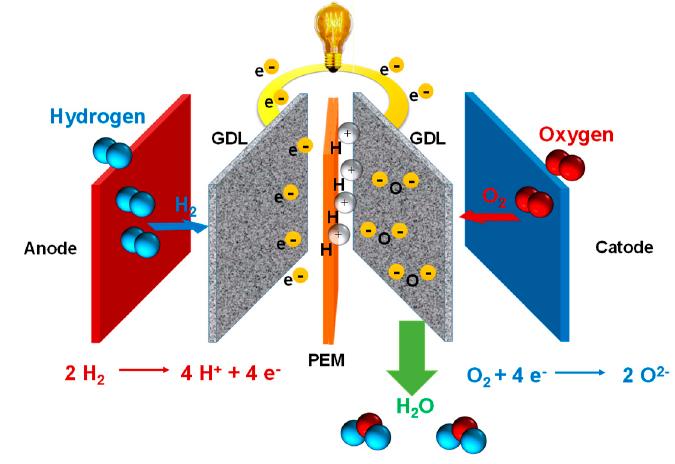
Figure 1. Schematic flow of PEMFC.